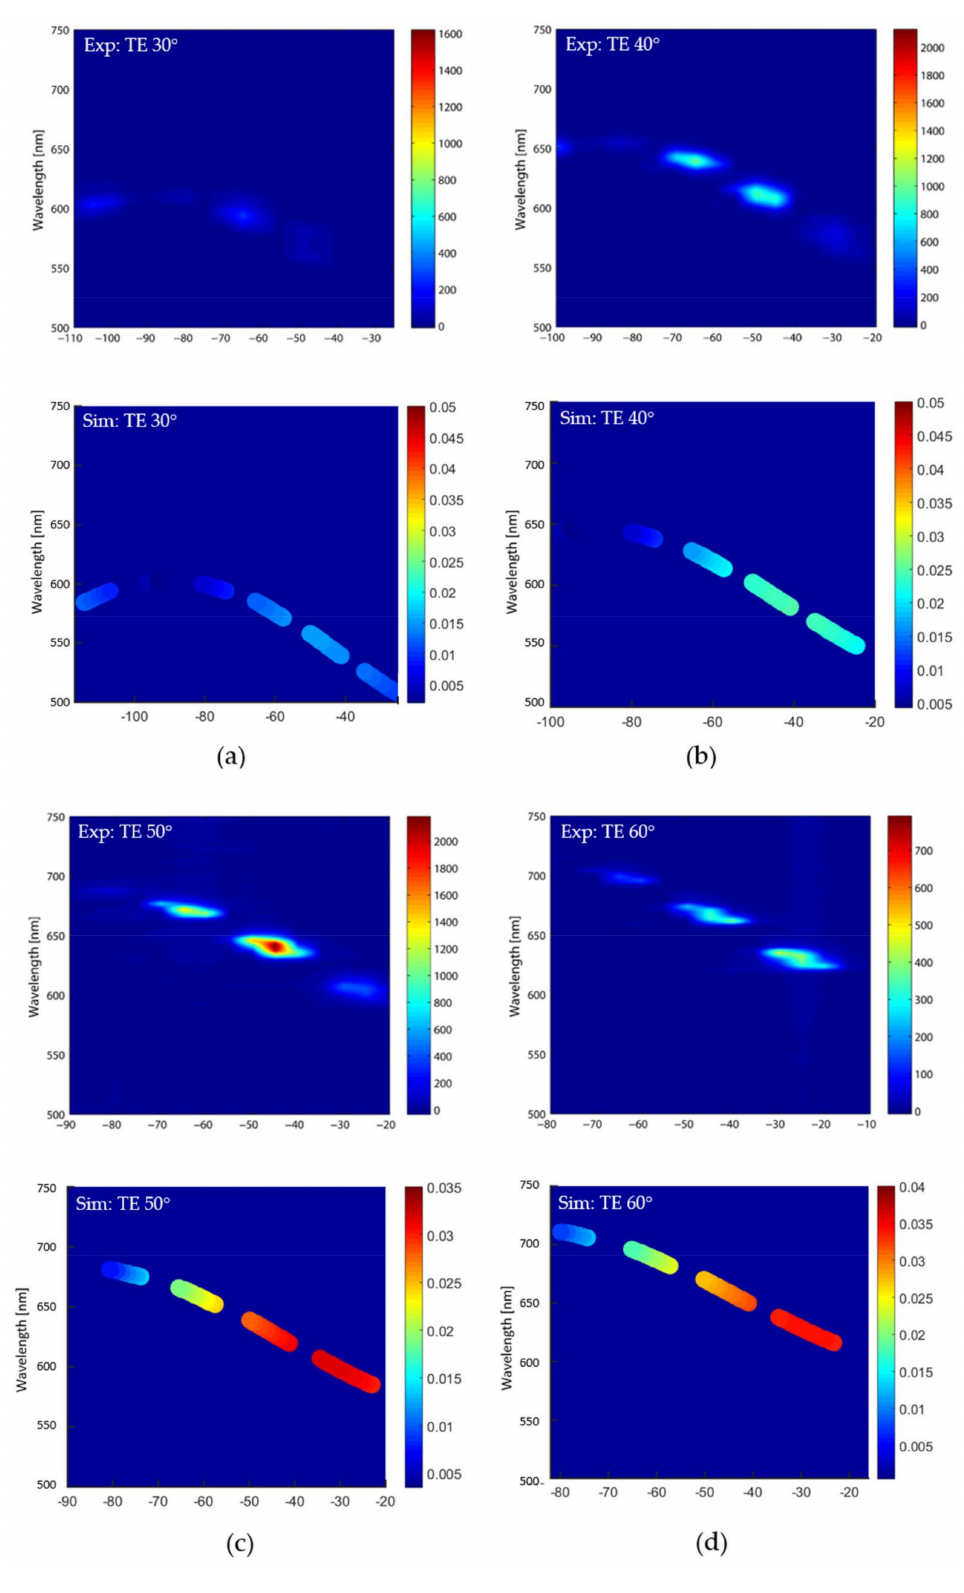
Figure 7. Experimental (top panels) and simulated (bottom panels) spectral-angular map of TE polarized incident light for incident angles 30 ◦ ( a ), 40 ◦ ( b ), 50 ◦ ( c ), and 60 ◦ ( d ). The intensity scales are in the same units for all maps of the TE polarization. Simulated data are matched to experimental data by considering maximum intensity in a